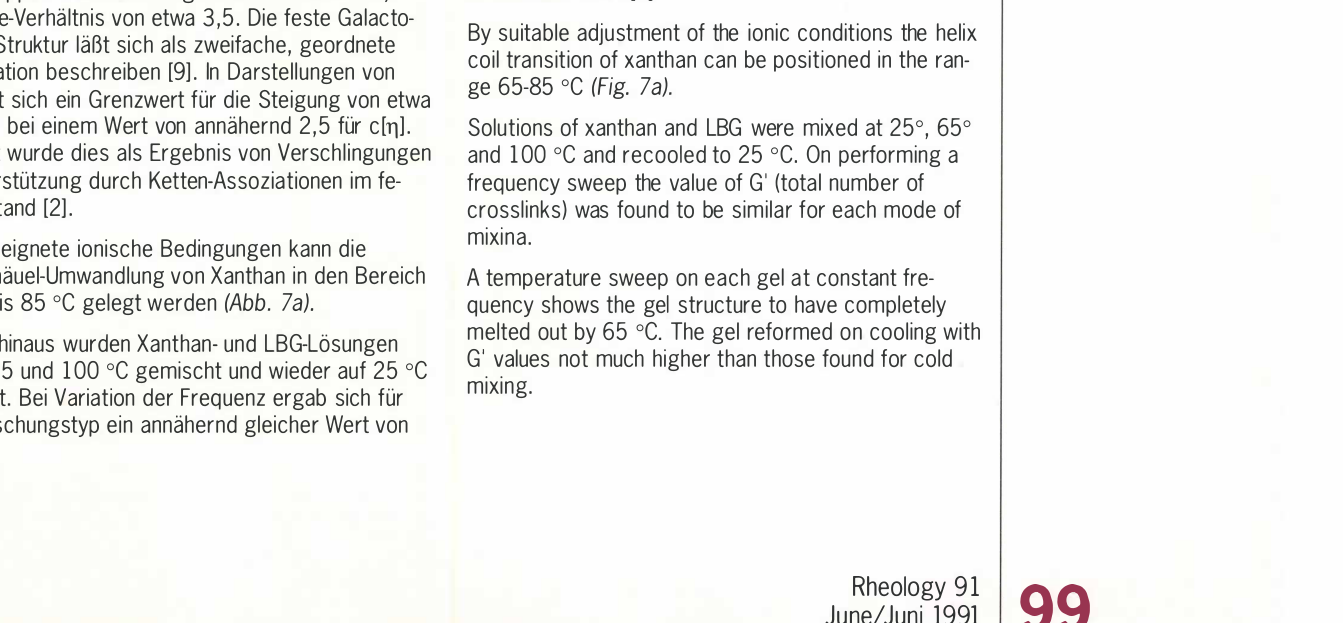
mannose: galactose ratio of 3,5. In the solid state the galactomannan adopts an ordered two fold conforma­ tion [9]. Plots of cl11l show a limiting slope of 5 with c *